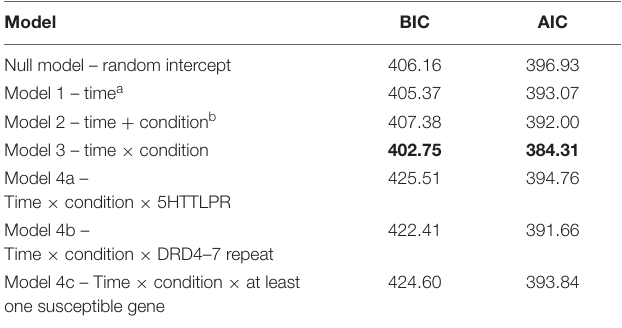
TABLE 1 | VIPP-FC/A intervention effects on maternal Emotional Availability.